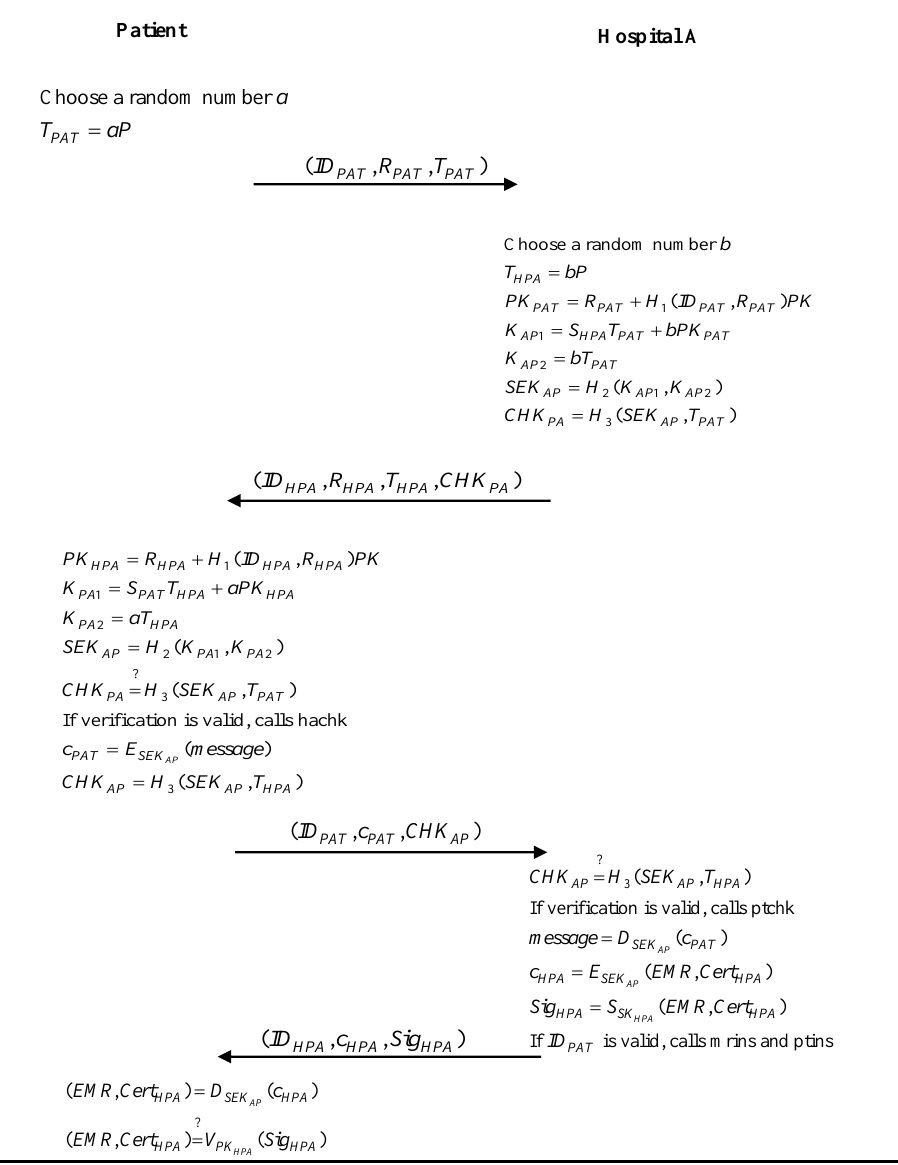
Figure 5. The initial treatment authentication and communication phase of the proposed scheme.